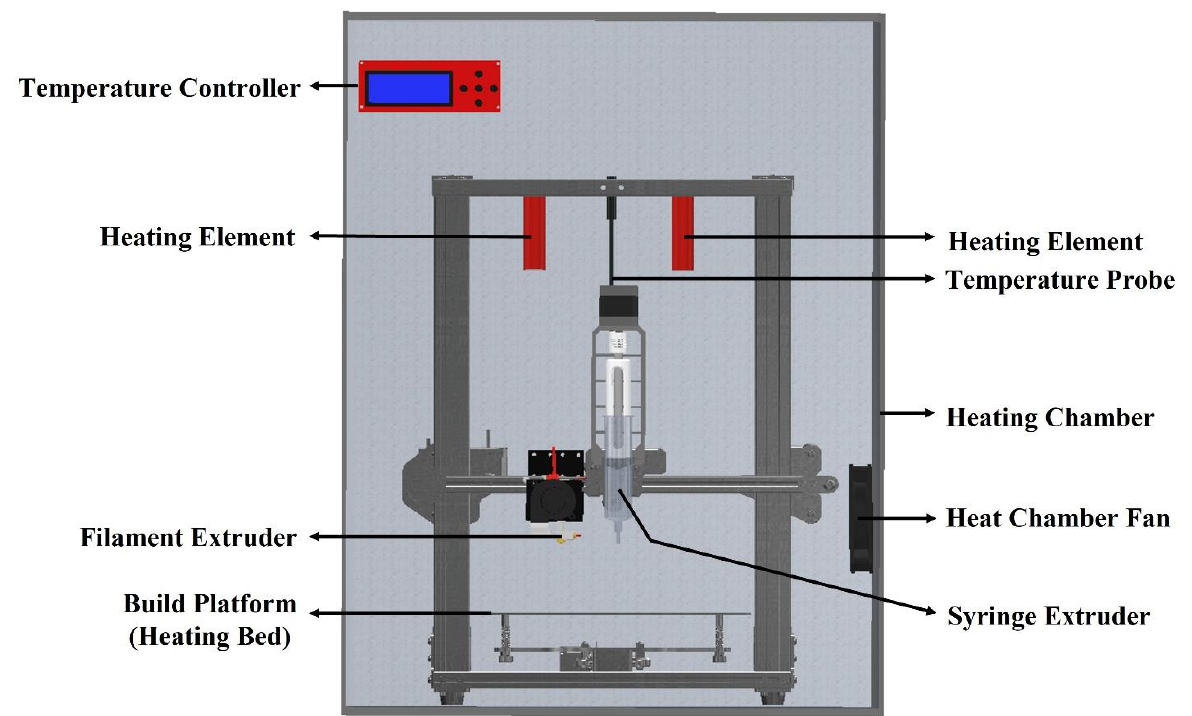
Figure 1. CAD model of composite plastic manufacturing